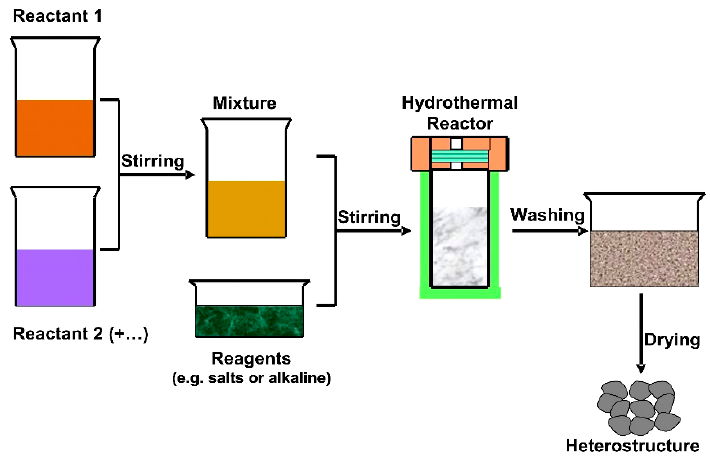
Figure 5. The hydrothermal method for heterostructure development.